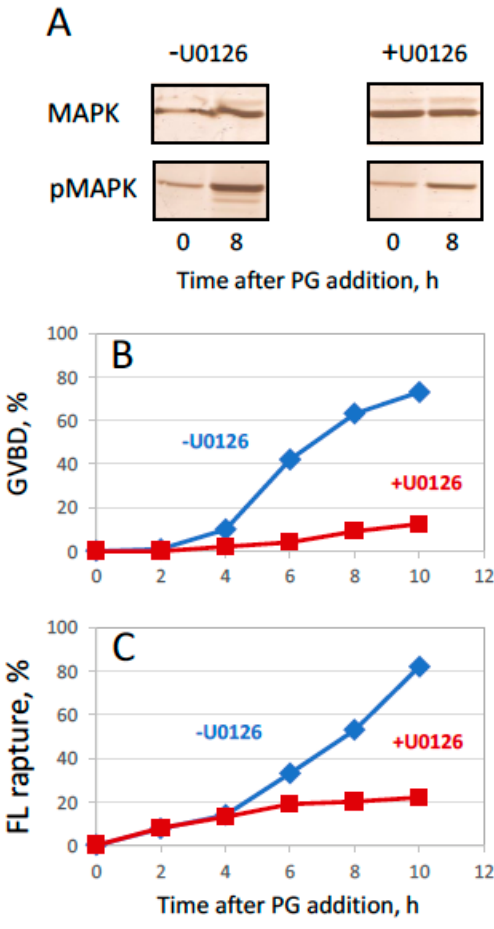
Figure 6. Effect of MAPK pathway inhibition on maturation and defolliculation. ( A ) Phosphorylation status of MAPK in the absence or presence of an MAPKK inhibitor during in vitro ovulation of Xenopus oocytes. The MAPKK inhibitor U0126 was added to the follicular oocytes at a final concentration of 50 µM at the time of PG administration. ( B , C ) Time courses of GVBD and follicular rupture, respectively. The experiment was repeated with four batches of follicular oocytes obtained from different animals and the results of a single batch experiment are presented.